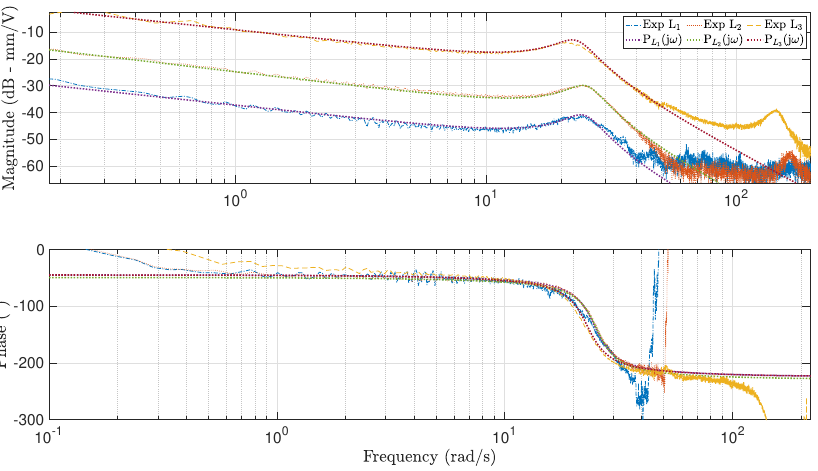
Figure 7. Comparison of experimental and model frequency responses of the AEF swimming robot by exciting the first actuator and measuring the deflection at the end of each